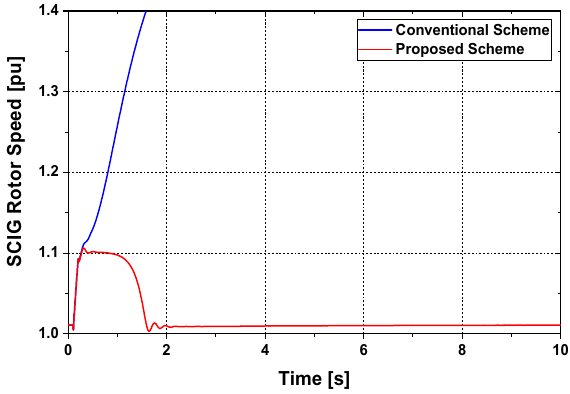
Figure 12. Rotor speed performance of SCIG.